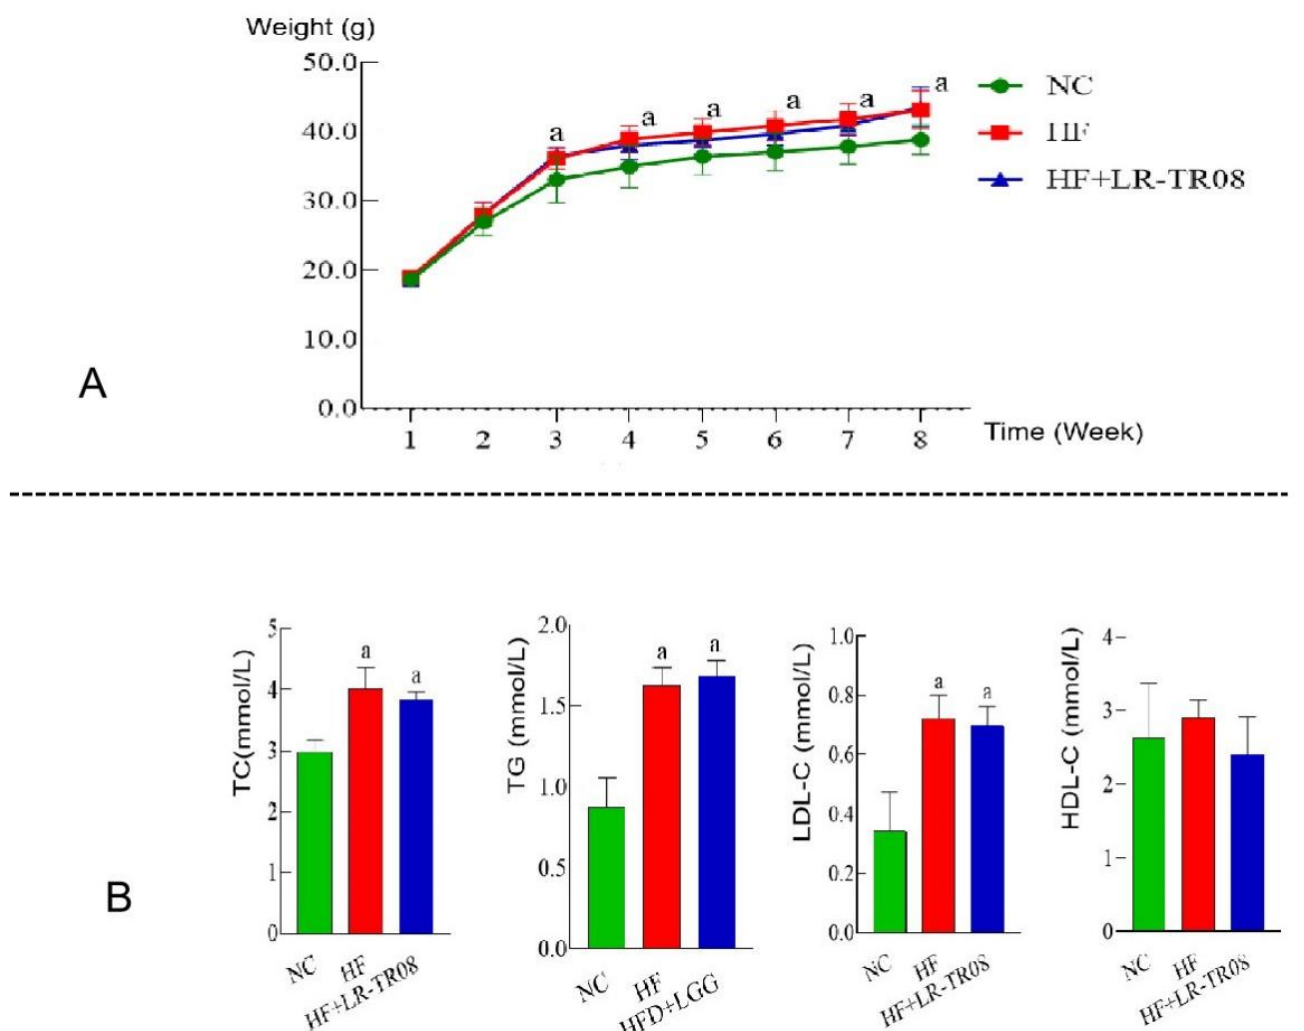
Figure 1. The change of body weight and blood lipid index in HF feed mice. ( A ): the weight change, ( B ): the changes of total cholesterol (TC), triglyceride (TG), low − density lipoprotein − cholesterol (LDL − C), and high − density lipoprotein − cholesterol (HDL − C). a: compared with the NC group, p < 0.05. Normal control group: NC, high ‐ fat diet group: HF, and high − fat diet + L. rhamnosus TR08 strain group: HF+LR − TR08.